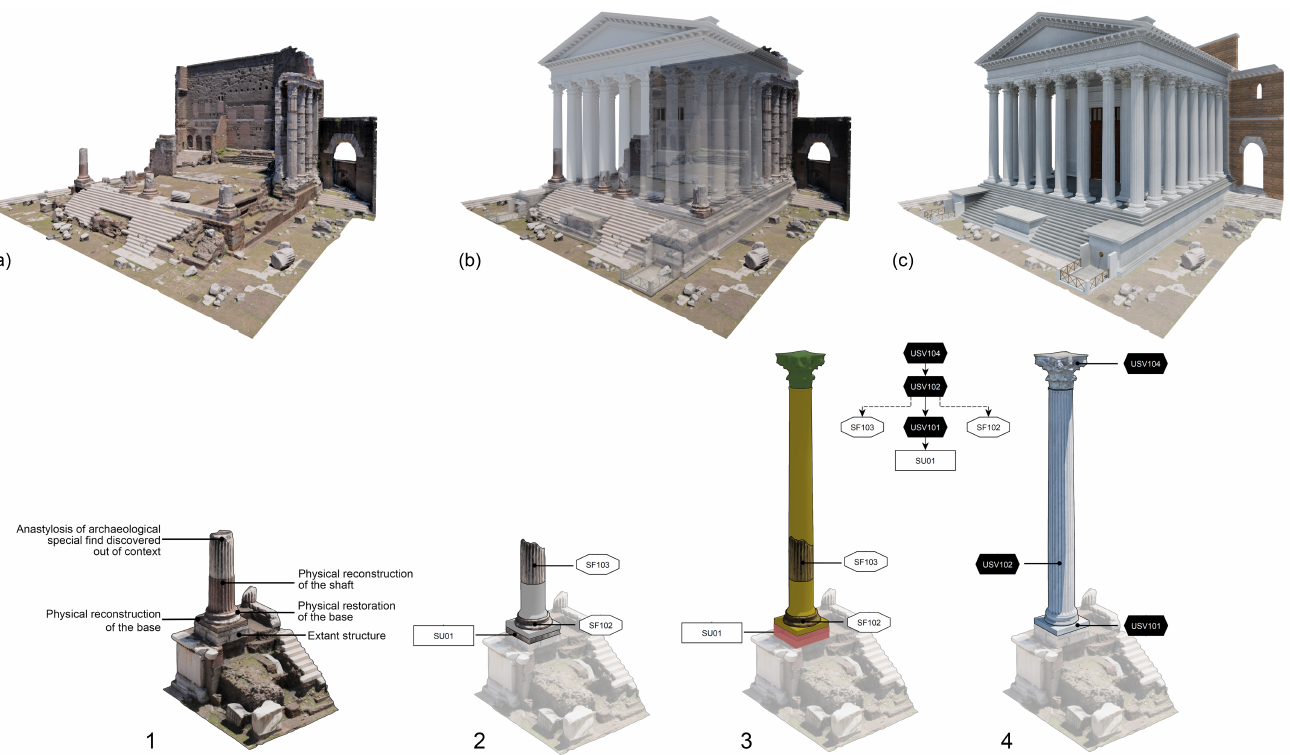
Figure 4. Virtual reconstruction of the Temple of Mars Ultor in the Forum of Augustus. Above: the examples shows different model created within this project: ( a ) Actual model; ( b ) Reconstructive model (only volumes); ( c ) Representation model (geometry, shaders and textures). Below: example of the first 4 steps of the EM workflow applied on a column of the porticus : ( 1 ) Digital replica and data collection; ( 2 ) Data management and analyses; ( 3 ) Interpretation and virtual reconstruction (proxy model) ( 4 ) representation model. See colour chart in Table